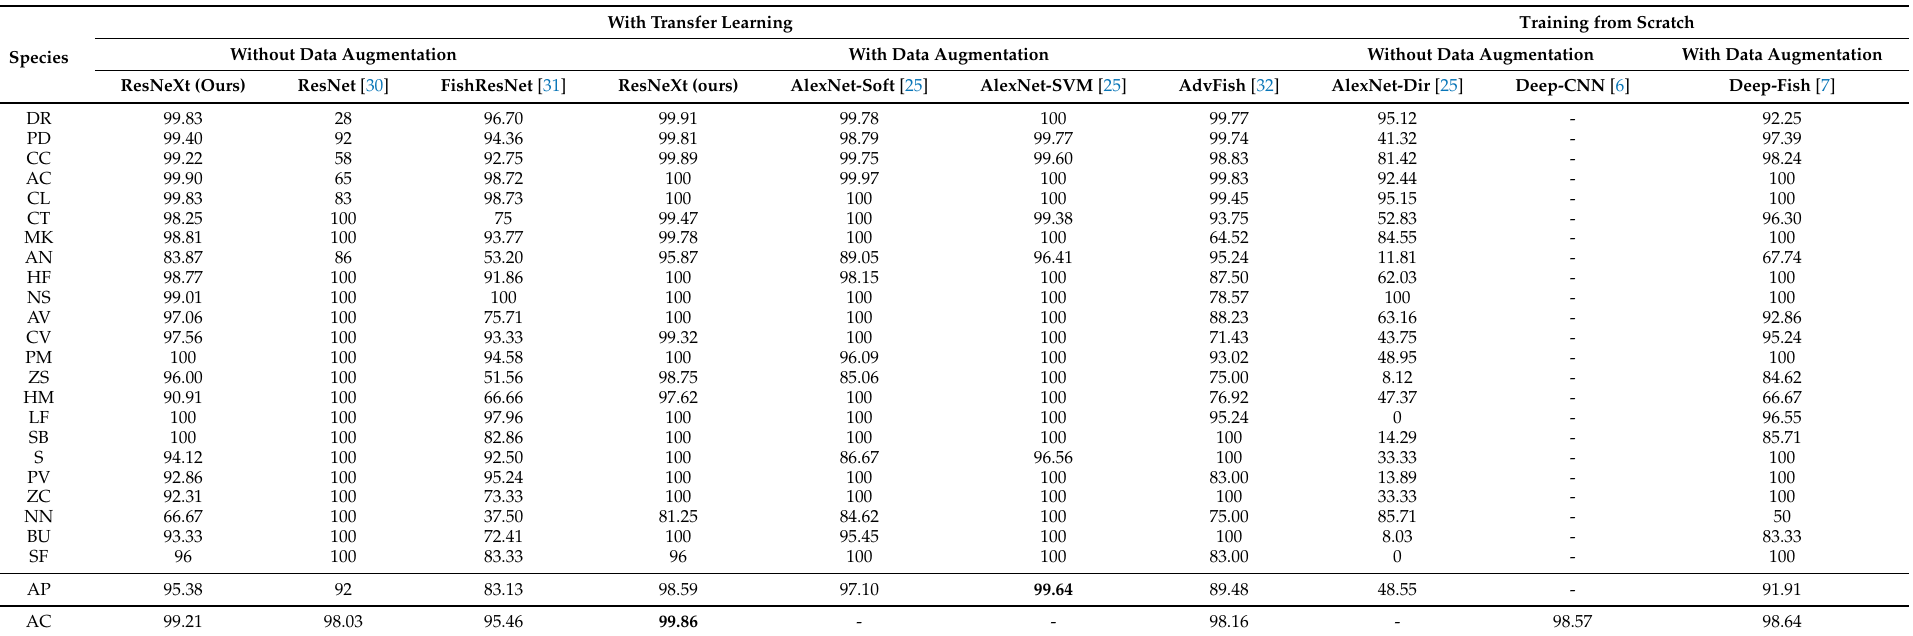
Table 8. Comparison of fish recognition performances of various methods on the FRGT